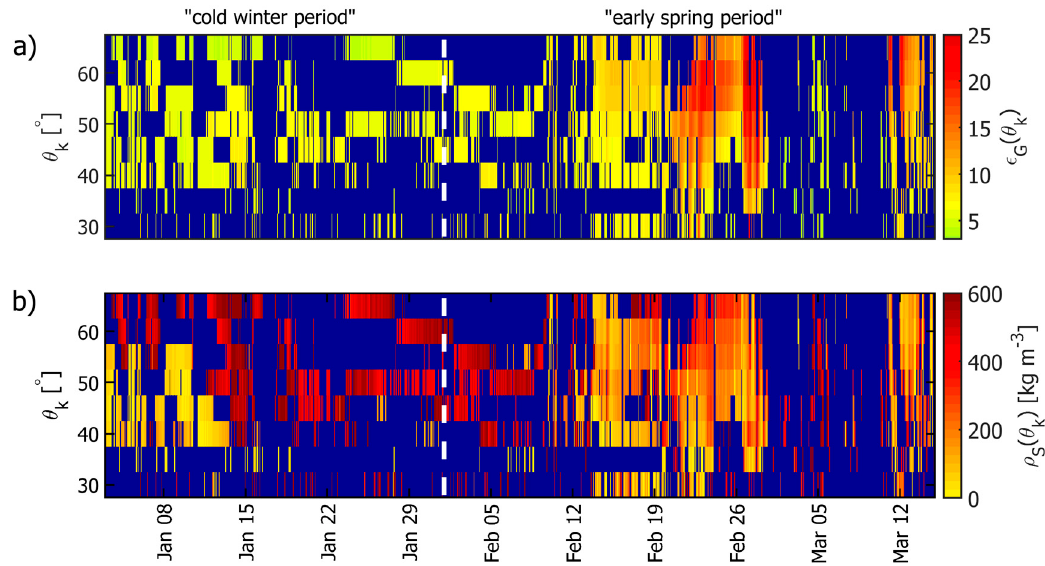
Figure 9. ( a , b ) Time series of the footprint-specific ε G ( θ k ) and ρ S ( θ k ) single-angle retrievals from 3 January (first snow event) to 15 March (end of measurement campaign). Colored bars show the color code of the retrievals performed at nadir angles θ k labelled on the left vertical axes. Failed retrievals are shown in blue.